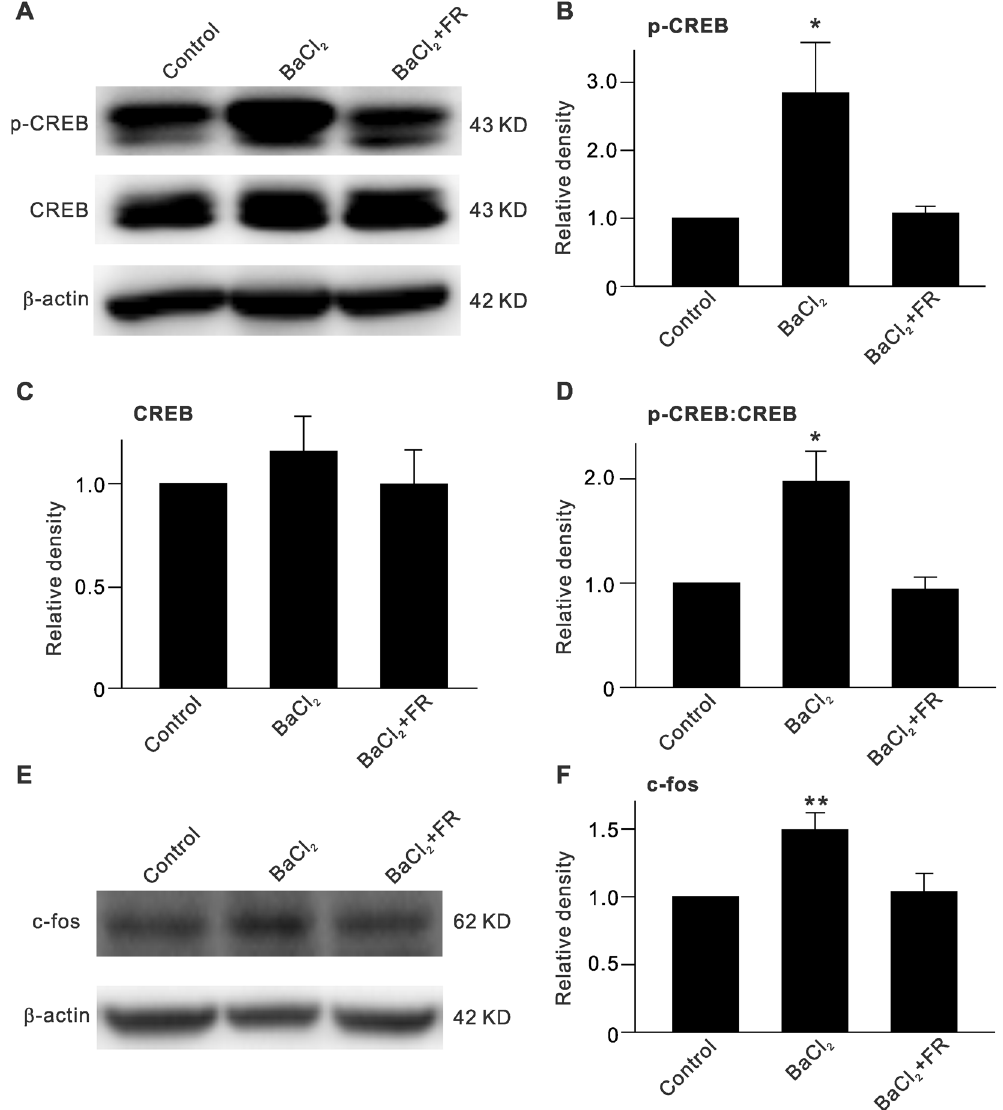
Figure 4. ERK-induced increase in p-CREB and c-fos expression in BaCl 2 -injected retinas. ( A ) Representative immunoblots showing changes in p-CREB and CREB expressions in retinas with vehicle (Control)-, BaCl 2 - or BaCl 2 + FR180204-injection. ( B , C ) Bar charts summarizing the average densitometric quantification of immunoreactive bands of p-CREB ( B ) and CREB ( C ) protein expression under different conditions. ( D ) Bar charts summarizing the average p-CREB:CREB ratios under different conditions. ( E ) Representative immunoblots showing changes in c-fos expression. ( B ) Bar charts summarizing the average densitometric quantification of immunoreactive bands of c-fos protein expression under different conditions. Note that BaCl 2 injection-induced increase in protein levels of p-CREB and c-fos, and ratio of p-CREB:CREB was reversed by co-injection of the ERK inhibitor FR180204. n = 6 for each group. * P < 0.05 and ** P < 0.01 vs .